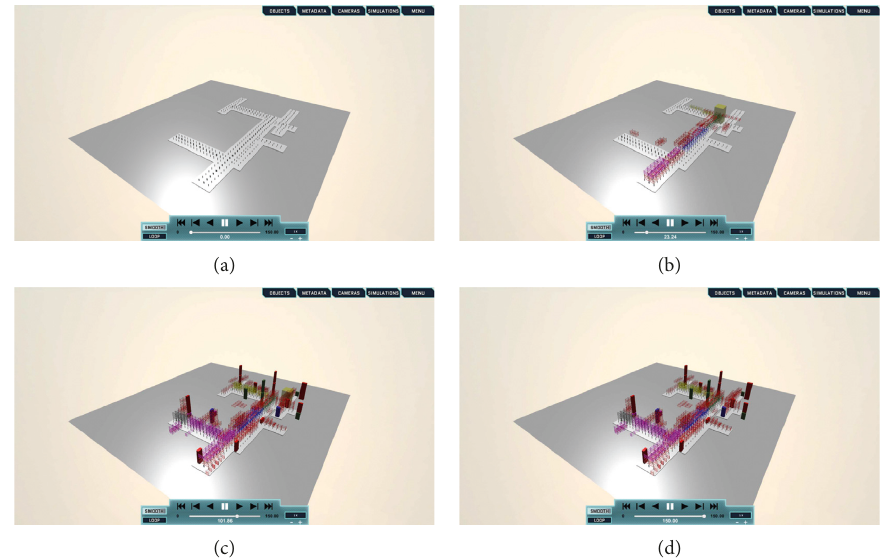
Figure 9: This is the same project shown in Figure 8, but we added the scaffold (the transparent objects in the second and third frame).